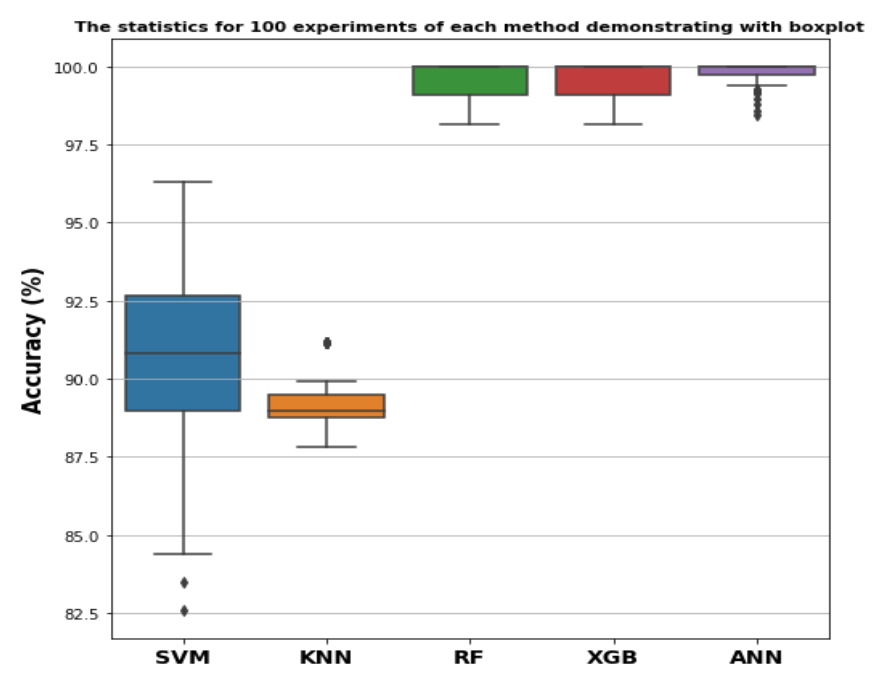
Figure 12. The boxplot represents the accuracy matrix of over 100 experiments for the SVM, KNN,